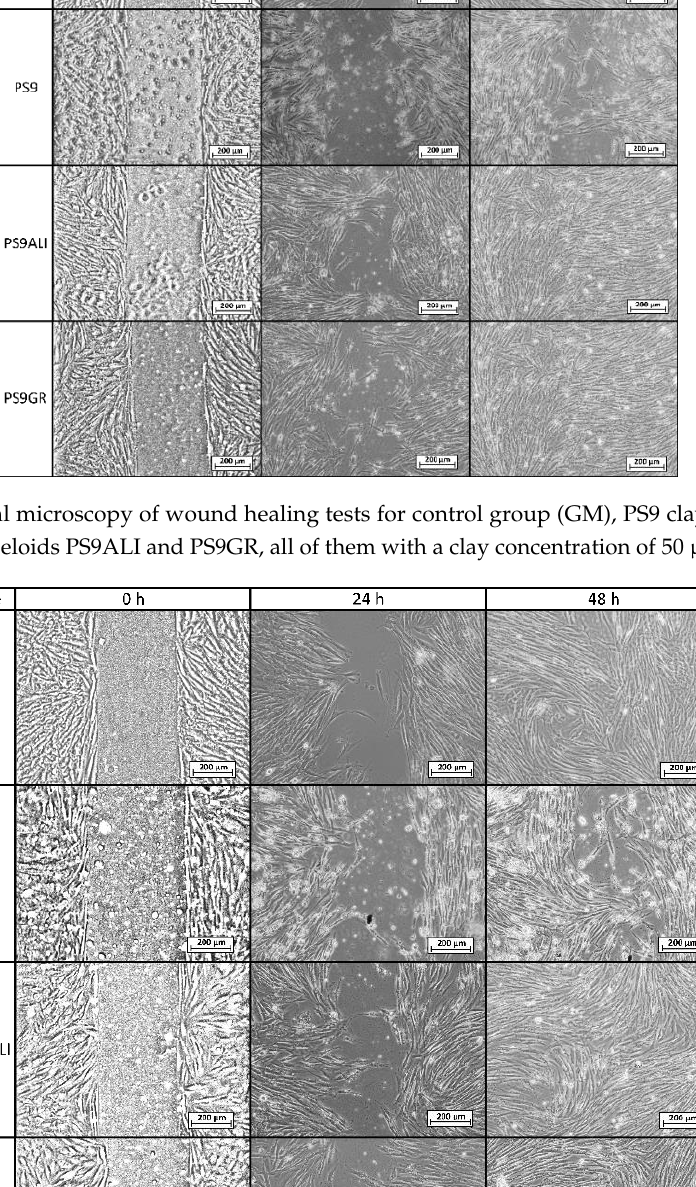
Figure 7. Optical microscopy of wound healing tests for control group (GM), G30 clay mineral and corresponding peloids G30ALI and G30GR, all of them with a clay concentration of 50 μg/mL.